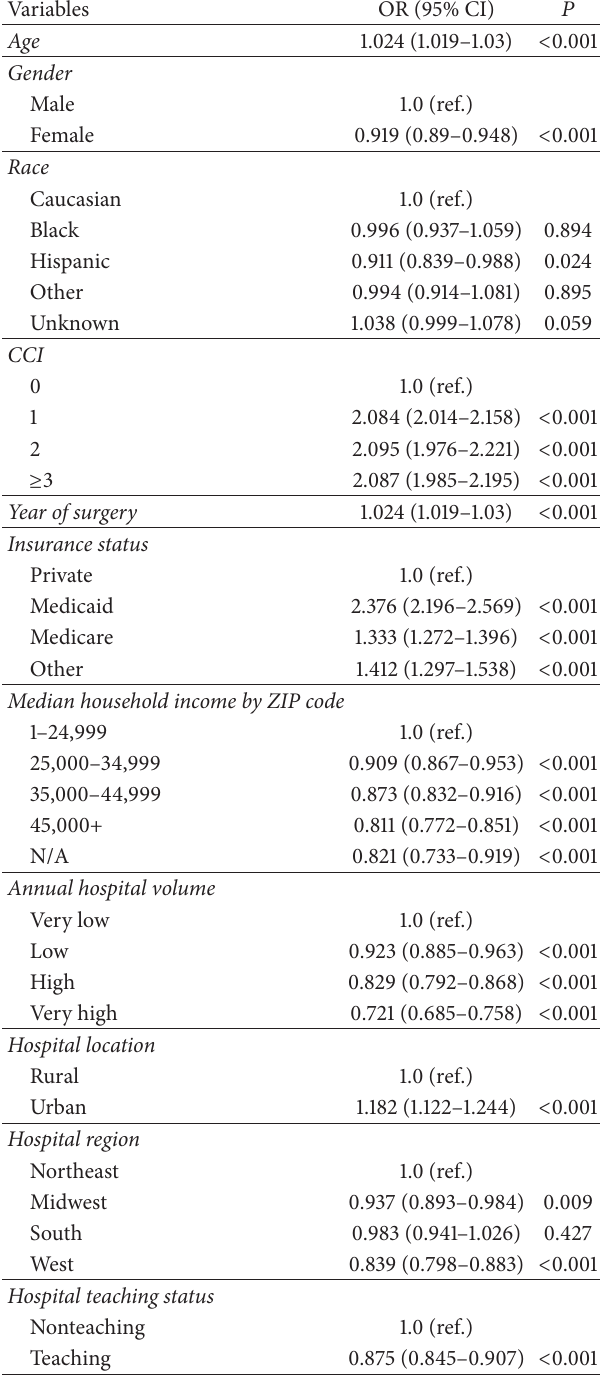
Table 2: Multivariable logistic regression analysis predicting the occurrence of pneumonia following major cancer surgery,